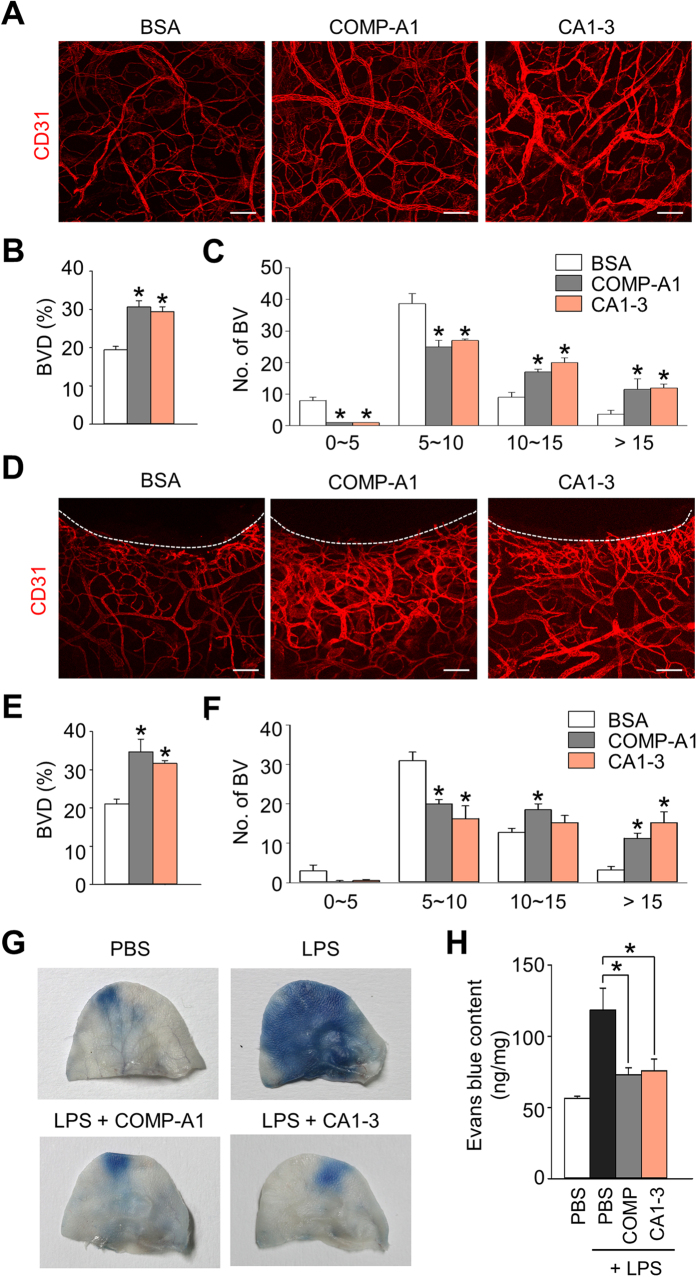
Dimeric CMP-Ang1 induces angiogenesis and prevents vascular permeability in vivo.(A–F) One μg of BSA, CA1-3 and COMP-Ang1 were intradermally injected to normal ears (A–C) and hole-punch injury ears (D–F) every 12 hr for 7 days. Blood vessels in normal ear skin (A) and wound margin of ear skin (D) were visualized by CD31 immunostaining. Blood vessel densities (BVD) (B,E) and numbers of different-sized vessels (C,F) in the normal and wound margin of ear skin were measured. Each graph indicates the mean ± SD of five experiments. Scale bars, 100 μm. *p < 0.05 versus BSA. (G,H) Ears were treated intradermally with PBS, LPS, or LPS with CA1-3 or COMP-Ang1 and then Evans blue dye was injected intravenously to visualize plasma leakage. Gross images of Evans blue dye extravasation in ears (G) and its quantification (H). Each graph indicates the mean ± SD of four experiments. *p < 0.05 versus LPS-treated group.